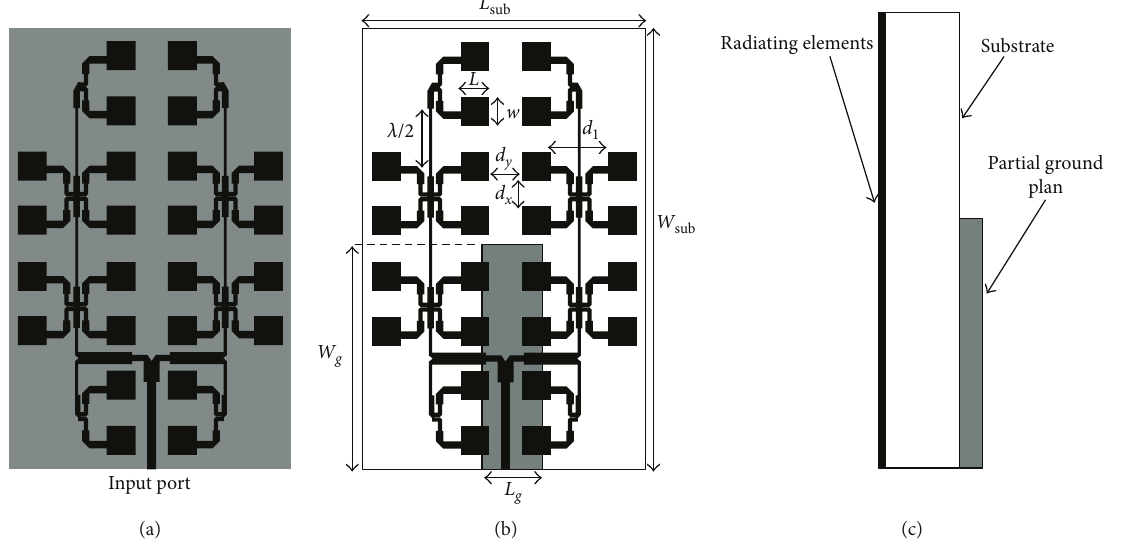
Figure 3: Geometry of the proposed UWB array antennas. (a) Array antennas with total ground plan, (b) array antennas with partial ground plan, and (c) the side view of the array antennas.